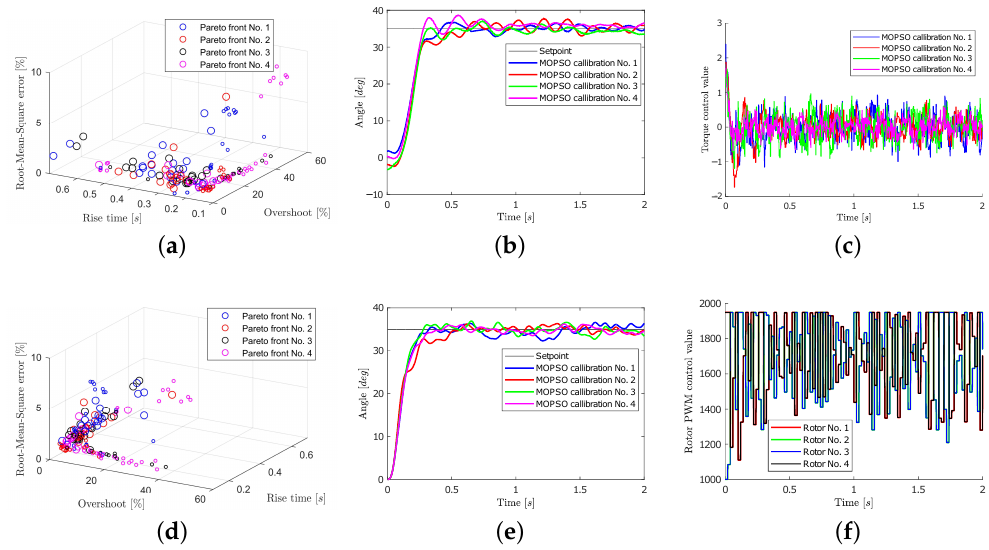
Figure 8. Results obtained for the roll axis. ( a ) Pareto front (the bigger particles represent the ones without oscillation hazard). ( b ) Experimental step response. ( c ) Torque control values. ( d ) Pareto front in a different perspective. ( e ) Simulation step response. ( f ) Pulse-width modulation (PWM) control value (calibration number 1).